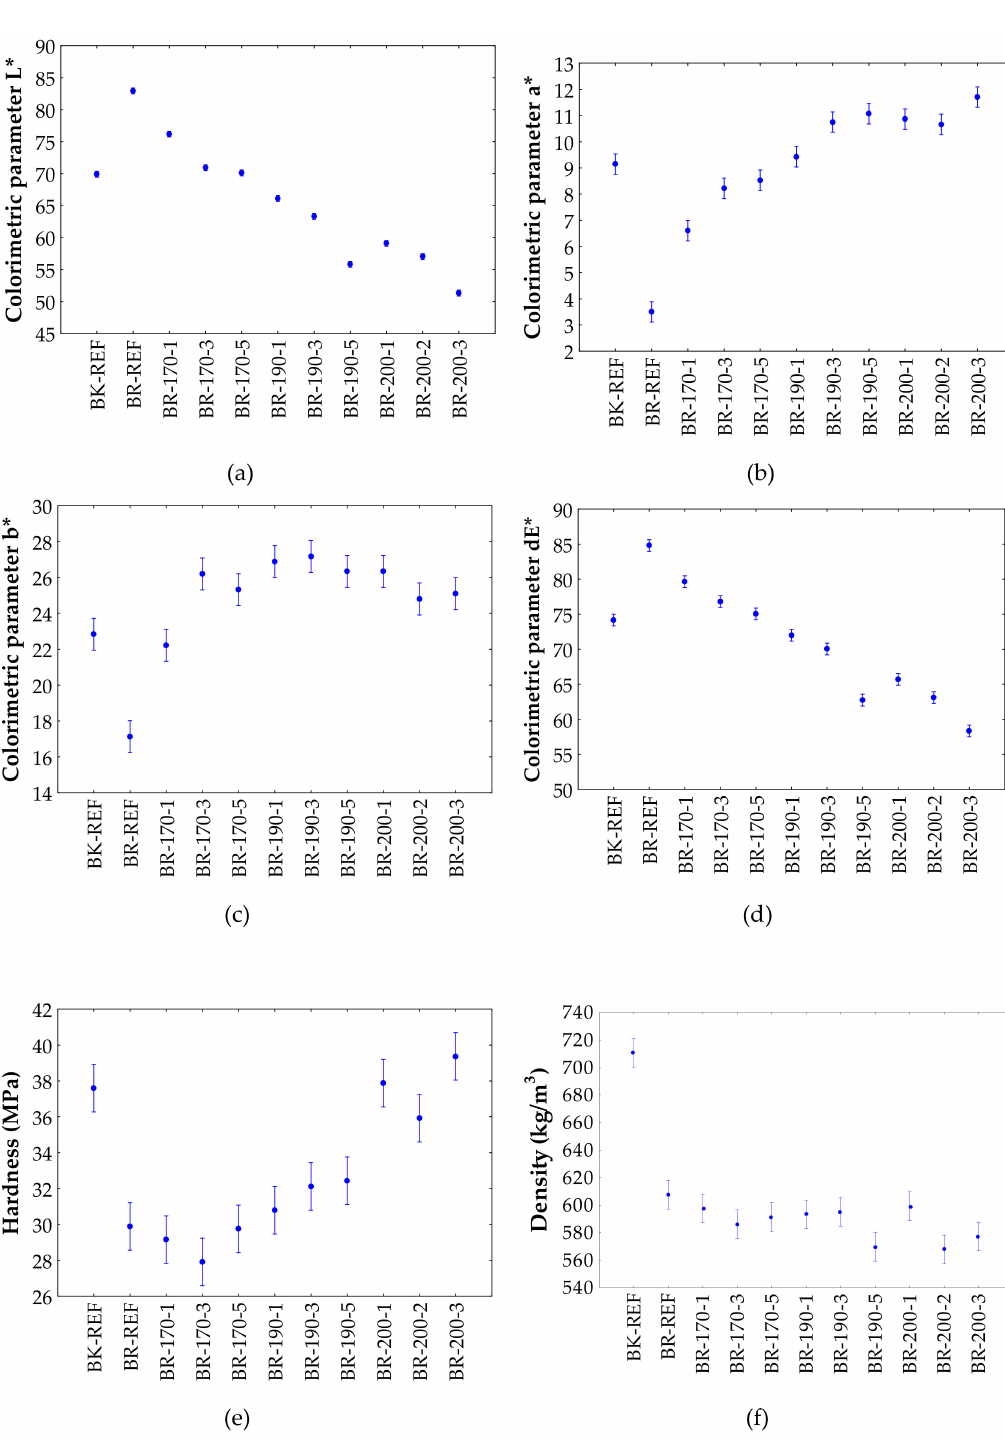
Figure 8. The graphic visualization of the e ff ect of heat-treatment temperature and heat-treatment time limit (peak stage) on colorimetric parameters ( a ) L*, ( b ) a*, ( c ) b*, ( d ) dE*, ( e ) hardness and ( f ) density. BK-REF = untreated beech; BR-REF = untreated birch; BR-170-1 = birch treated at 170 ◦ C / 1 h; BR-170-3 = birch treated at 170 ◦ C / 3 h; BR-170-5 = birch treated at 170 ◦ C / 5 h; BR-190-1 = birch treated at 190 ◦ C / 1 h; BR-190-3 = birch treated at 190 ◦ C / 3 h; BR-190-5 = birch treated at 190 ◦ C / 5 h; BR-200-1 = birch treated at 200 ◦ C / 1 h; BR-200-2 = birch treated at 200 ◦ C / 2 h; BR-200-3 = birch treated at 200 ◦ C / 3 h. L* = brightness; a* = value in the green-red axis; b* = value in the blue-yellow axis; dE* = total color di ff